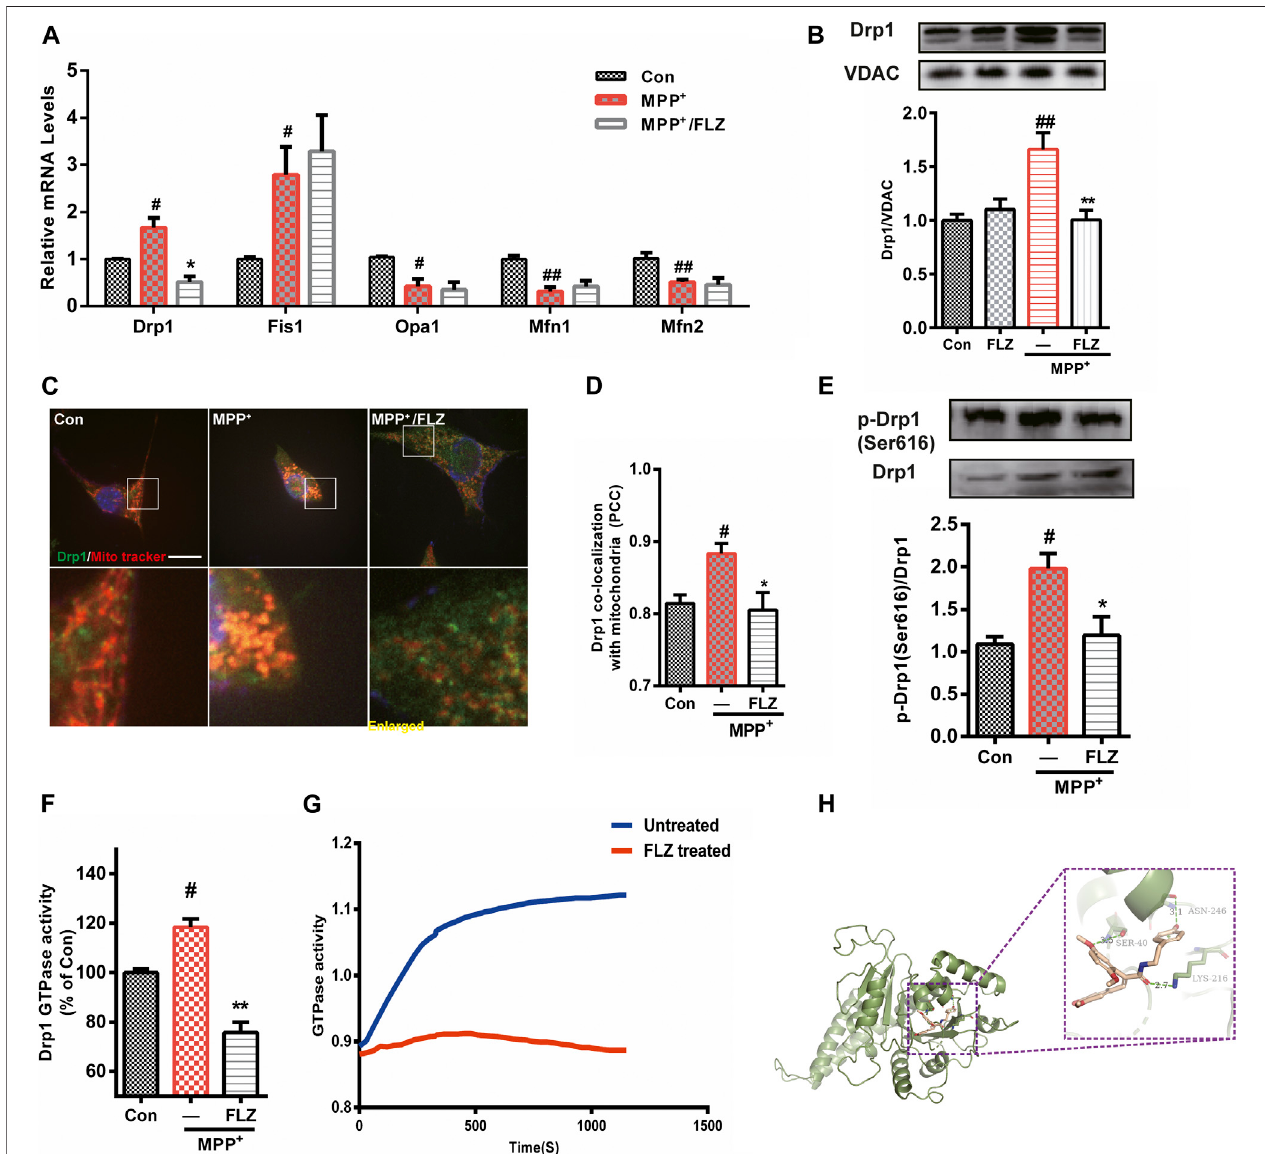
FIGURE 3 | FLZ treatment reduced Drp1 association with mitochondria and decreased Drp1 GTPase activity. Cultured SH-SY5Y cells were treated with FLZ (10 μ M)for30 minfollowedbyincubationwithMPP + (2 mM)for4 h (A) mRNAexpressionofmitochondrialdynamicassociatedproteinswereanalyzedbyqRT-PCR. (B) Western blot analysis of mitochondrial fractions of cells was determined by Drp1 and VDAC antibodies. VDAC was used as a loading control (C) Drp1/mitochondria colocalization was determined by confocal analysis. Cells were stained with Drp1 antibody (green), mitotracker (red) and DAPI (blue). Lower panels show enlarged areas of the white boxes in the above panels (scale bar: up: 20 μ m, down: 4 μ m). (D) Pearson ’ s coef fi cient per cell of Drp1/mitochondria colocalization was determined using Image-pro Plus software and is provided as a histogram (E) p-Drp1 (Ser616) level of SH-SY5Y cells was measured by western blot analysis with p-Drp1 (Ser616) and Drp1 antibodies (F) The GTPase activity of immunoprecipitated Drp1 from cultured cells was measured by the Enzyme Linked Inorganic Phosphate Assay. (G) The GTPaseactivityofDrp1recombinantproteinwasmeasuredbytheEnzymeLinkedInorganicPhosphateAssay.100 ngDrp1recombinantproteinwereincubatedwithor without FLZ. Shown are representative data out of 4 independent experiments. (H) Docked molecular model of FLZ in the active site of the Drp1 (PDB ID: 4H1V). One- wayANOVAfollowedbyTukeyposthoccomparisonstestswereperformedinallstatisticalanalyses. # p < 0.05and ## p < 0.01vs.Controlgroup,* p < 0.05and ** p < 0.01 vs. MPP + treated